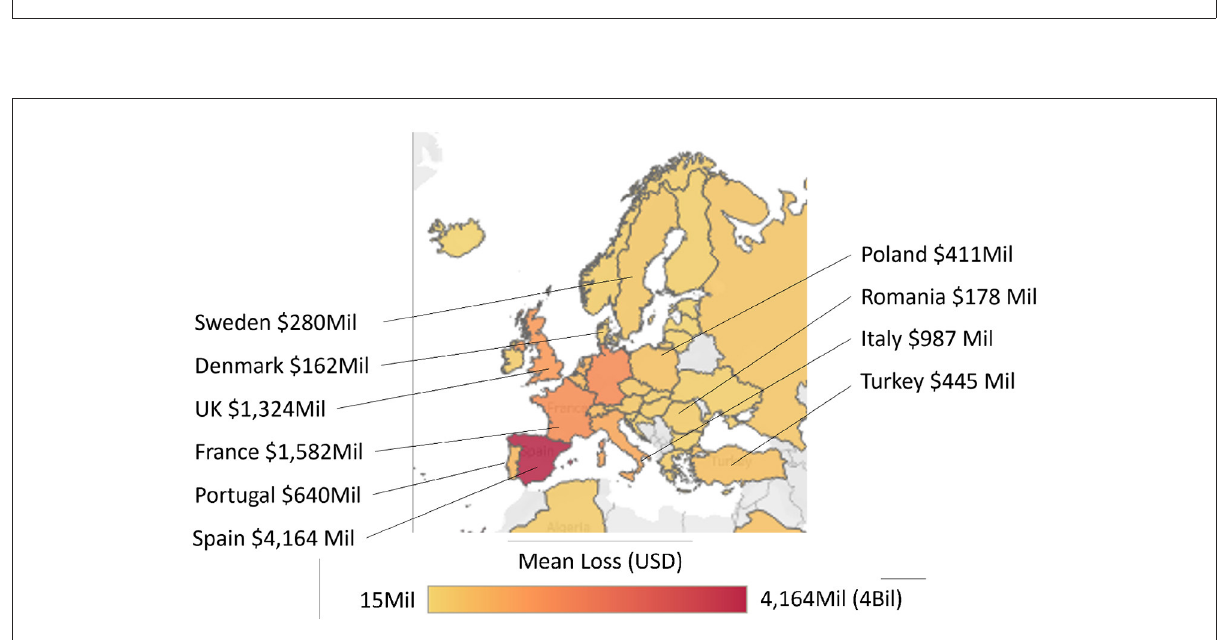
FIGURE11 EU heat map for loss, to easily show members of